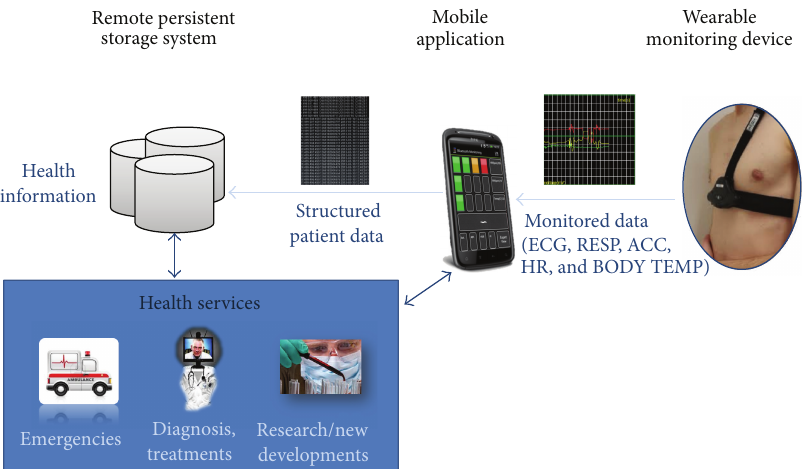
Figure 1: The PhysioDroid system. From right to left, the wearable monitoring device records the user’s vital signs and transmits them to the mobile device. The application running on the mobile device provides functionalities such as visualization and interpretation of the collected data, triggering of alarms and health alerts. The mobile device also serves as gateway to the remote persistent storage system, which provides advanced health services based on the analysis of medical data from multiple users.